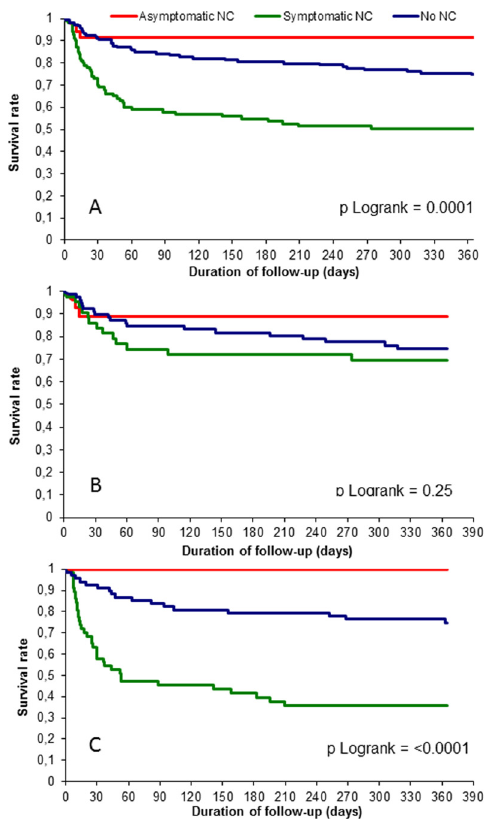
Fig 3. One-year survival curves of A) all patients with neuroimaging procedures (n = 283), B) operated patients (n = 150), C) non operated patients (n = 133) according to the presence and the type of neurological complications.